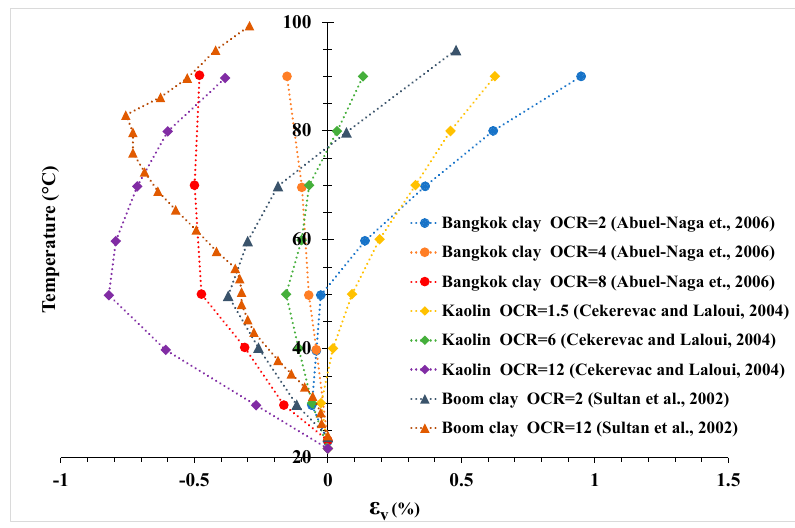
Figure 2. Volumetric change for over consolidated fine soil.